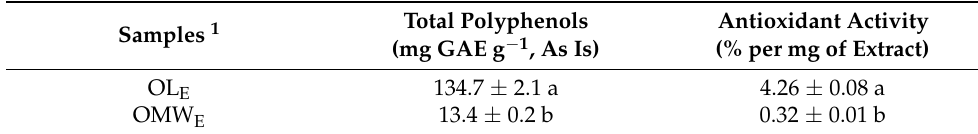
Table 1. Total polyphenol content and antioxidant activity of olive leaf and oil mill wastewater extracts.